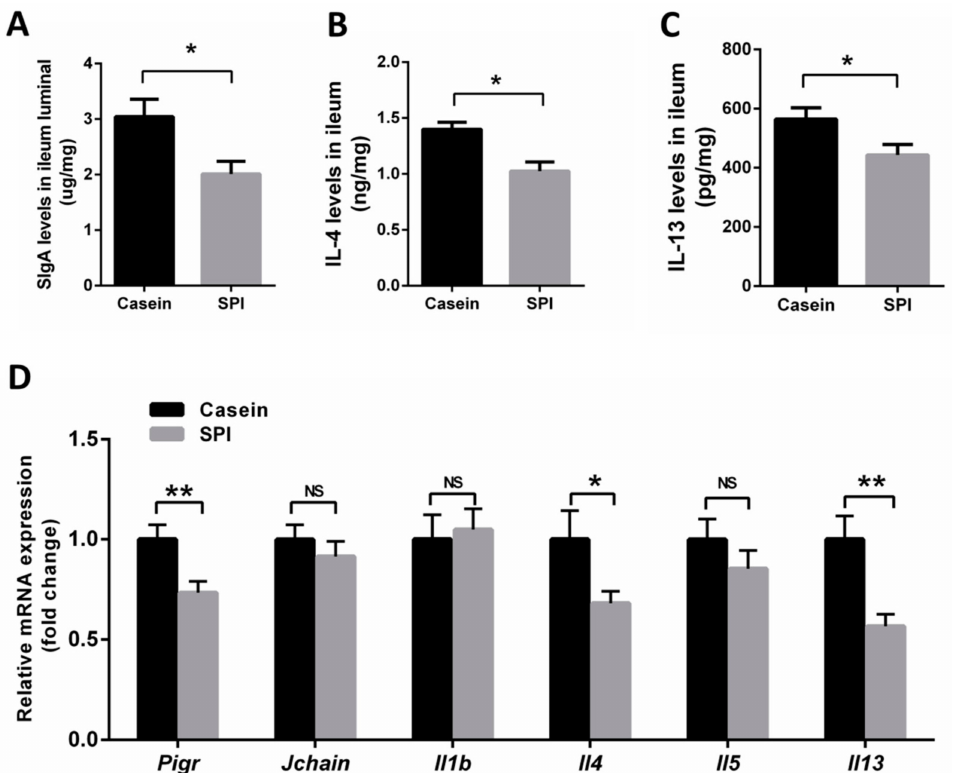
Figure 2. E ff ect of SPI on SIgA, IL-4, IL-13 and SIgA-associated mRNA levels in mouse ileum tissue. ( A – C ) ELISA analysis of SIgA, IL-4, and IL-13 levels in mouse ileum tissue, respectively ( n = 7). ( D ) qRT-PCR analysis of Pigr, Jchain, Il1 β , Il4, Il5 and Il13 mRNA expression in mouse ileum tissue (normalized against Actb ( β -actin); n = 8). All data are presented as means ± SEM. NS, not significant ( p > 0.05); * p < 0.05; ** p < 0.01. Statistical significance was calculated using t